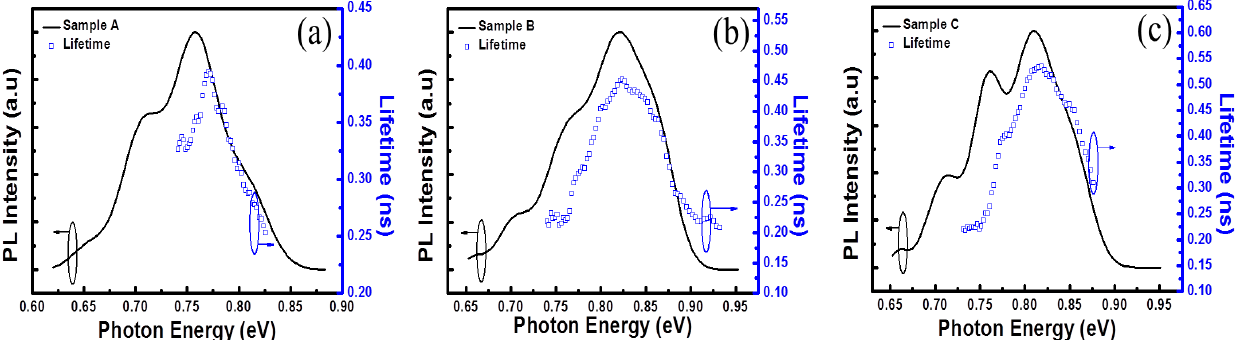
Figure 3. Energy-dependent, time-resolved photoluminescence of ( a ) sample A, ( b ) sample B and ( c ) sample C. The longest lifetimes of samples agreed with the main peaks, which indicates the strong localized states due to deep acceptors.